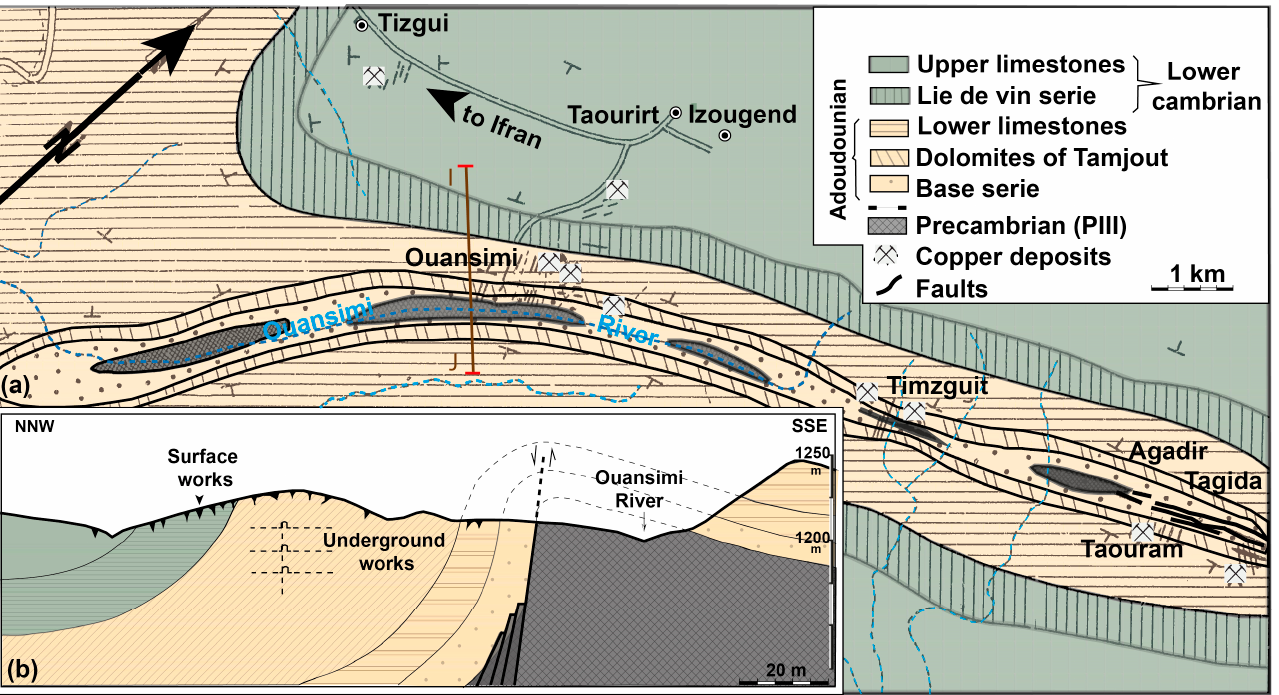
Figure 4. ( a ) Geological map of the Ouansimi district. ( b ) Geological cross-section I-J (modified after Smeykal [22]).